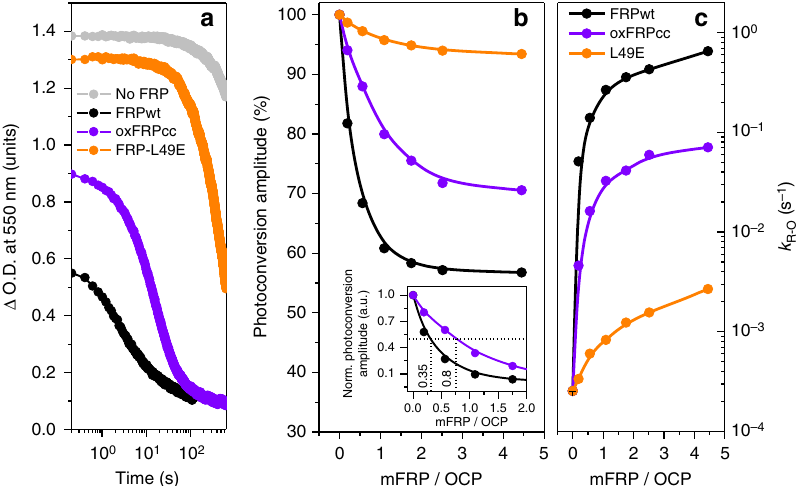
Fig. 7 Functional characterization of FRP variants with prede fi ned oligomeric state. a Characteristic time-courses of OCP R -OCP O relaxation in the absence or presence of FRP species [a fi xed ratio of ~1.7 FRP per OCP; monomeric FRP concentration (mFRP) was chosen] followed by changes of optical density (O.D.) at 550 nm after the actinic light is turned off. Maximal O.D. changes at 550nm which could be obtained in the presence of FRP species under constant illumination by the actinic light ( b ) – normalized to such values in the absence of FRP species, and, thus, representing the maximal concentration of OCP R normalized to values between 0 and 1 for dimeric FRP variants to show at which FRP/OCP ratio half-saturation occurs (insert). c Corresponding R- O conversion rates in the presence of different concentrations of FRP species. All experiments were conducted at 10 °C to reduce the rate of OCP R -OCP O conversion, which is otherwise extremely high in the presence of